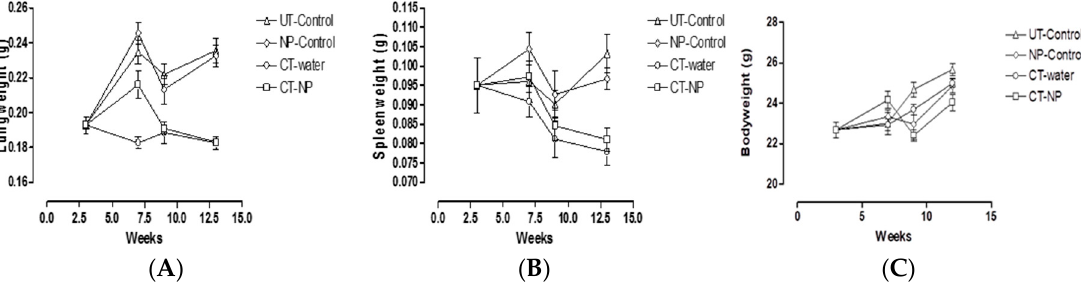
Figure 2. Overall kinetic changes in ( A ) lung, ( B ) spleen, ( C ) entire body, over the experimental period of 12